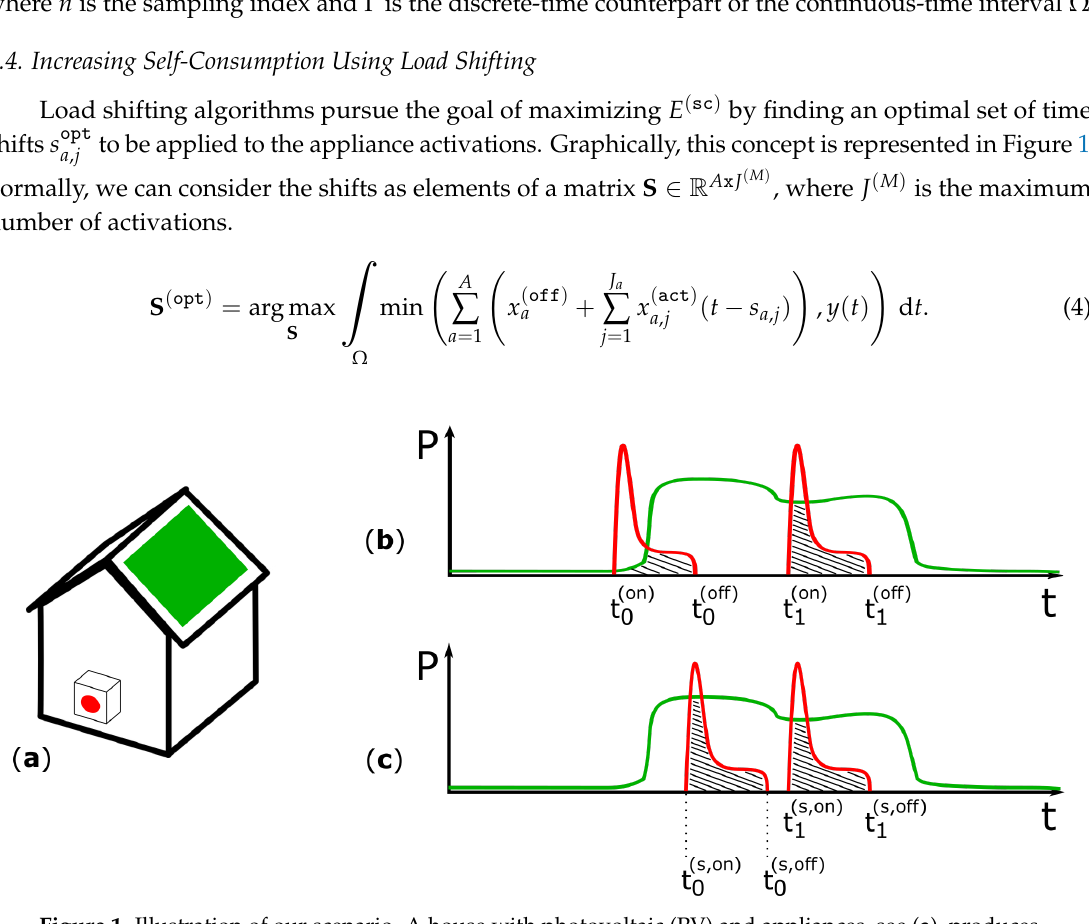
Figure 1. Illustration of our scenario. A house with photovoltaic (PV) and appliances, see ( a ), produces load and PV curves illustrated in ( b ). The dashed areas in ( a , b ) represent the amount of energy self-consumption. The shifted load in ( b ) increases self-consumption with respect to ( a